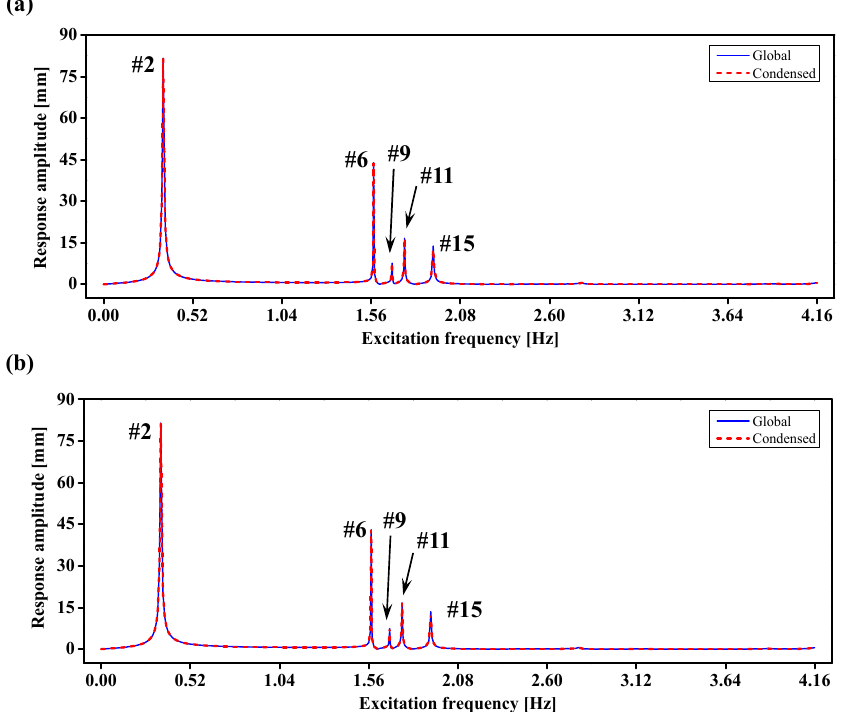
(cid:12) (cid:12) (cid:12) X g ( ω 0 ) (cid:12) and approximated response amplitude ω X ( ) and approximated response amplitude 0 g